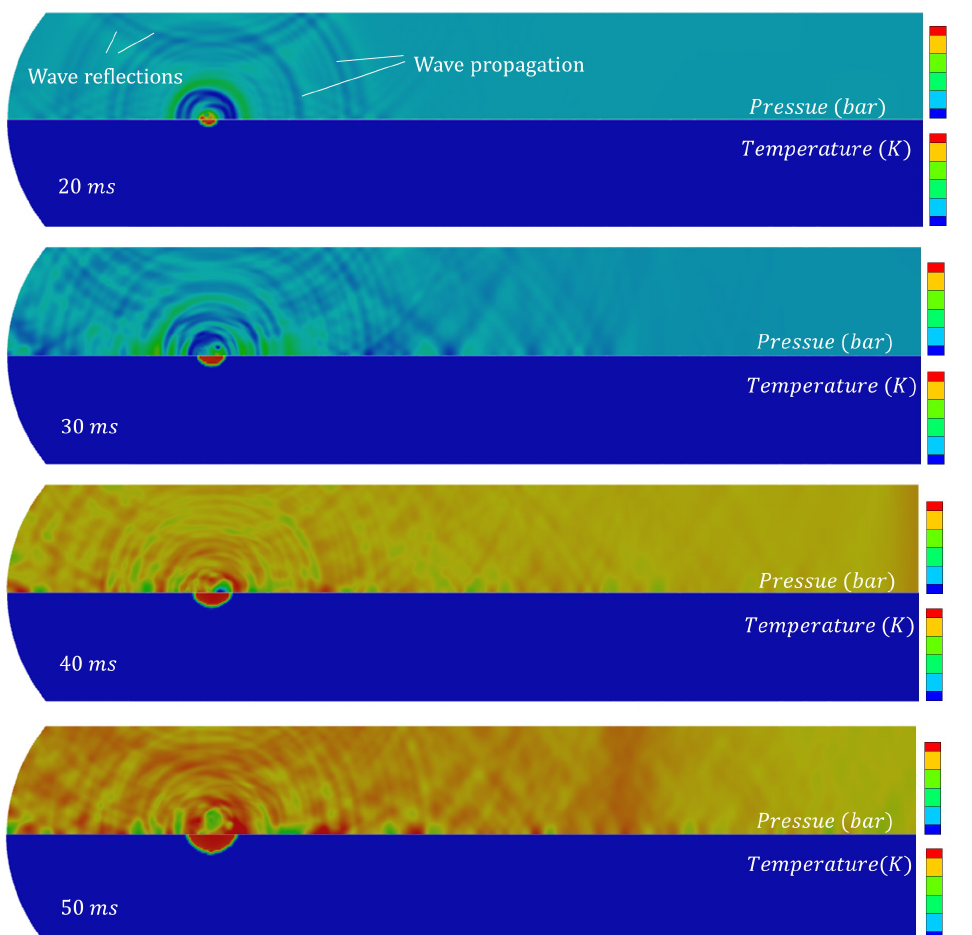
Figure 2. Contours of axial pressure ( top half ) and temperature ( bottom half ) immediately after igniting the methane–air mixture with 7.5% methane vented from